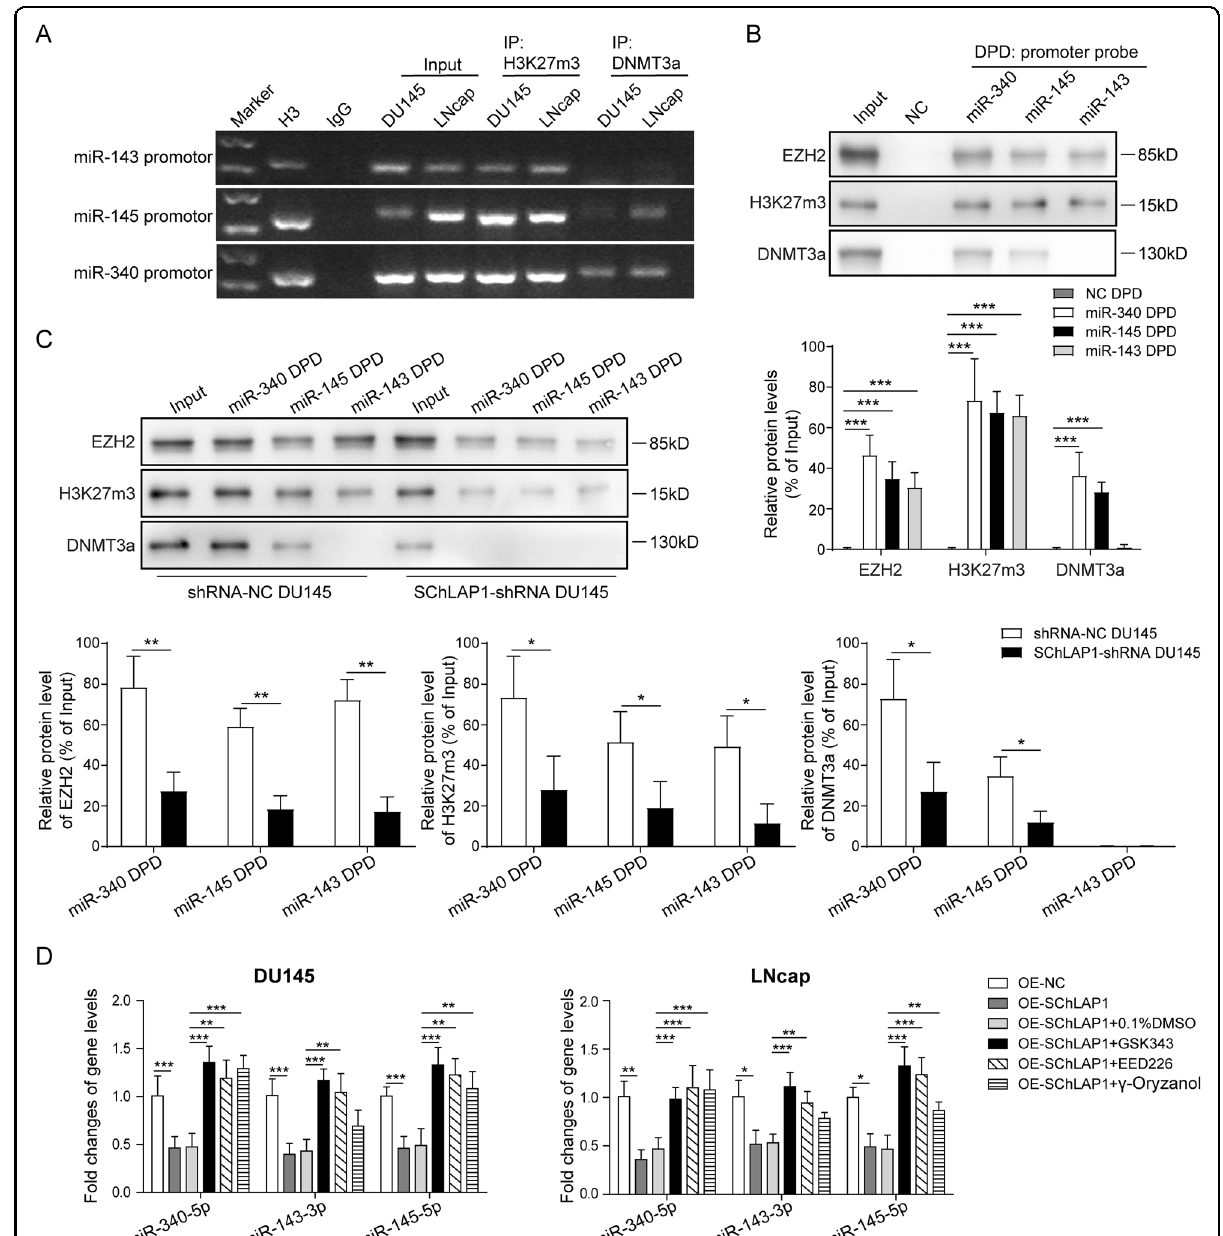
Fig. 4 SChLAP/EZH2/H3K27me3 mediated promoter methylation modi fi cation of miR-340-5p/miR-143-3p/miR-145-5p to suppress gene transcription. A ChIP assay using anti-H3K27me3 and anti-DNMT3a antibodies for the interactions between H3K27me3 and DNMT3a with the promoter sequences of miR-340-5p/miR-143-3p/miR-145-5p genes. B DNA pull-down assay combined with western blotting analysis for the binding of EZH2, H3K27me3, and DNMT3a to miR-340-5p/miR-143-3p/miR-145-5p gene promoter, respectively, in DU145 cells using special DNA probes or negative control probe. C DNA pull-down assay combined with western blotting analysis for the binding of EZH2, H3K27me3, and DNMT3a to miR- 340-5p/miR-143-3p/miR-145-5p gene promoter, respectively, in DU145 cell with SChLAP1 knockdown using special DNA probes. D Quantitative PCR assay for the effects of SChLAP overexpression, EZH2, H3K27me3, and DNMT3a inhibitors on miR-340-5p/miR-143-3p/miR-145-5p expression. The results are presented as the mean ± SD. * P < 0.05, ** P < 0.01. SChLAP1 second chromosome locus associated with prostate-1, EZH2 Enhancer of Zeste Homolog 2, H3K27me3 histone 3 lysine 27 tri-methylation, DNMT DNA